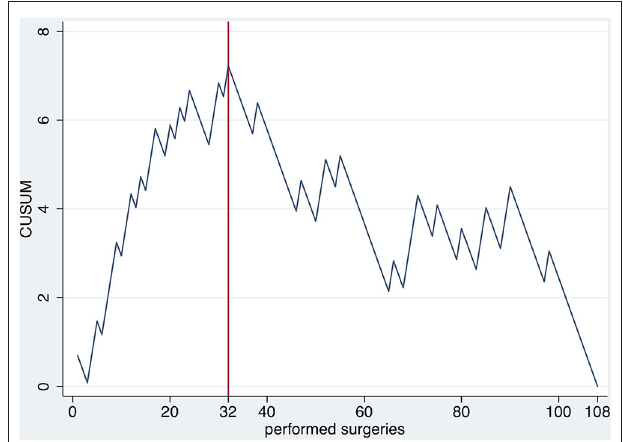
FIGURE 2 | CUSUM of the occurrence of long term complications over